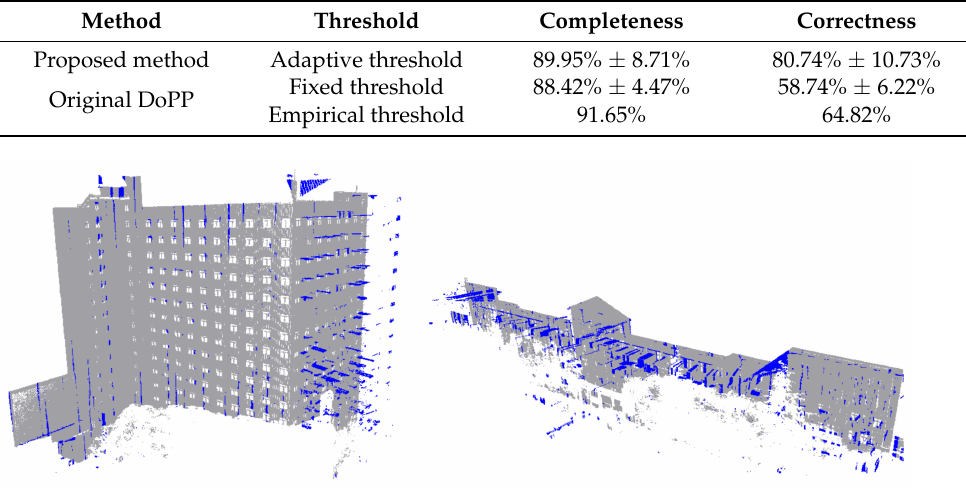
Figure 9. Example of the DoPP filtering results of our method from an indoor perspective with θ G and ρ G set as 0.2 ◦ and 1 m. Points are colored by the filtering result: preserved (gray) or filtered (blue). Most filtered points are indoor points, which are in front of the building points from the indoor